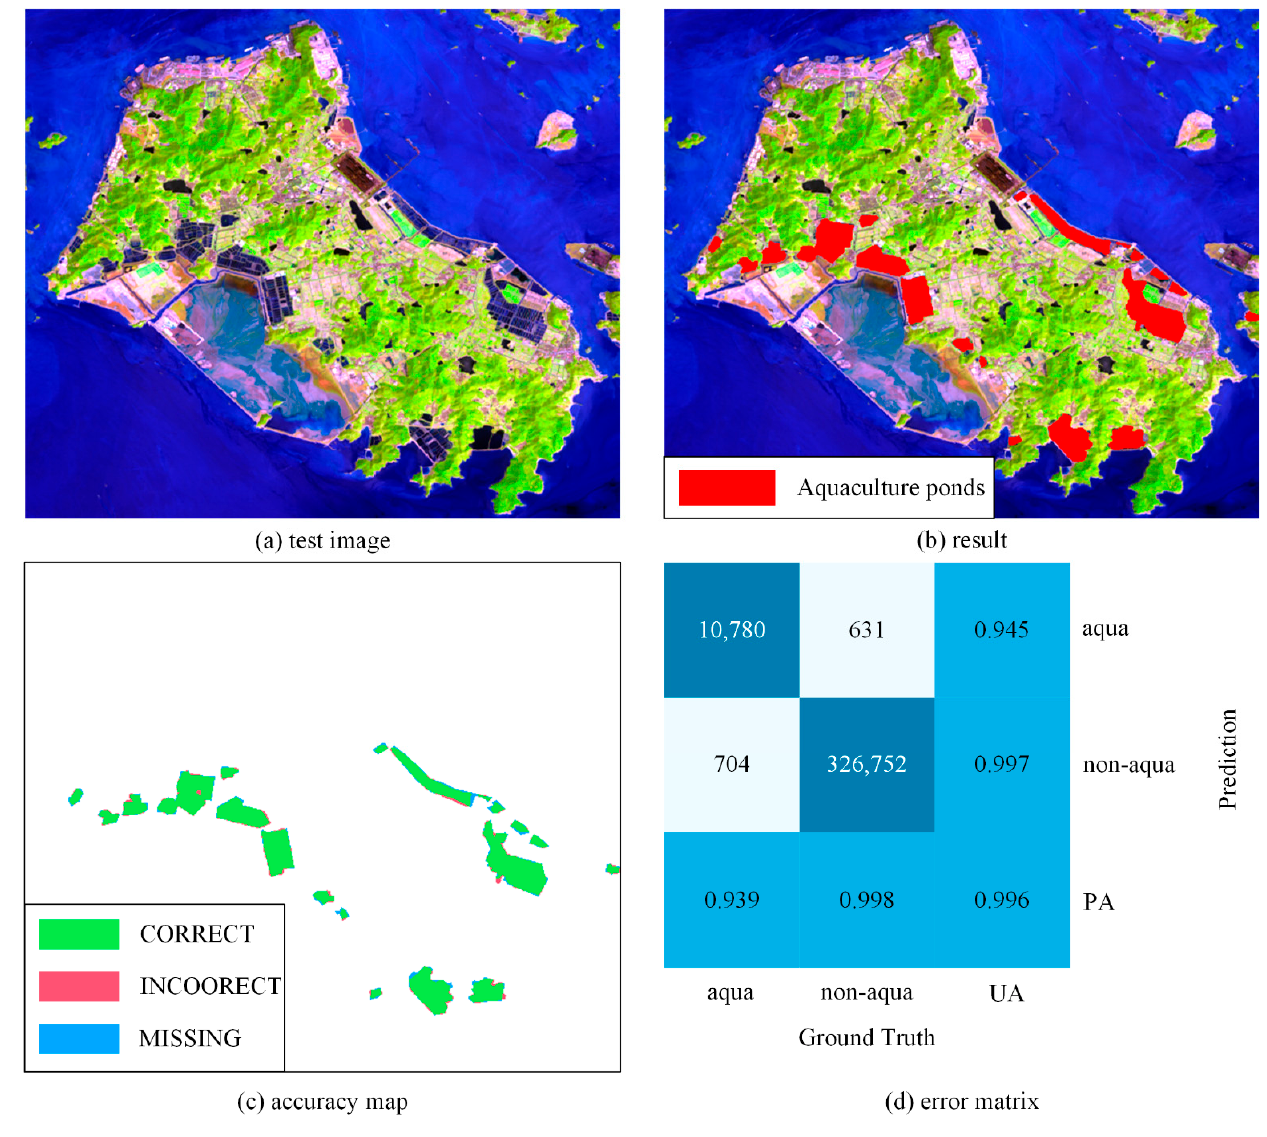
Figure 7. The extraction results of Liuheng Island: ( a ) original image, ( b ) extraction result, ( c ) accu- racy map, ( d ) error matrix. Table 2. Accuracy evaluation of coastal aquaculture ponds extraction in Liuheng Island, China. Number of Coastal Aquaculture